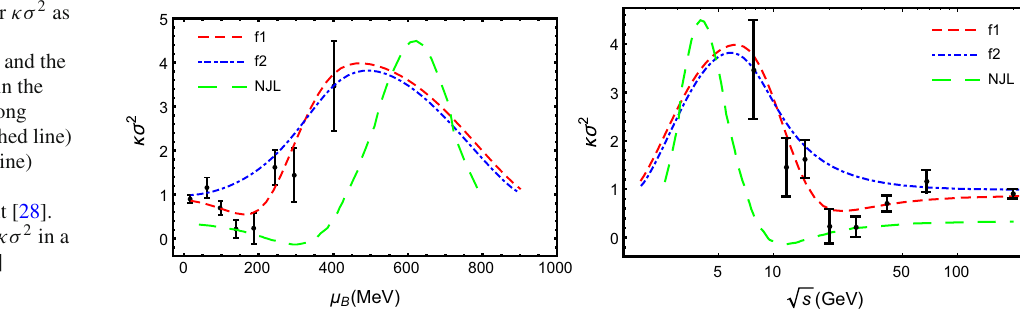
Fig. 10 The 2D plot for κσ 2 as a function of the baryon chemical potential (left) and the collision energy (right) in the realistic PNJL model along freeze-out lines f 1 (dashed line) and f 2 (dashed-dotted line) comparing with STAR Net-proton measurement